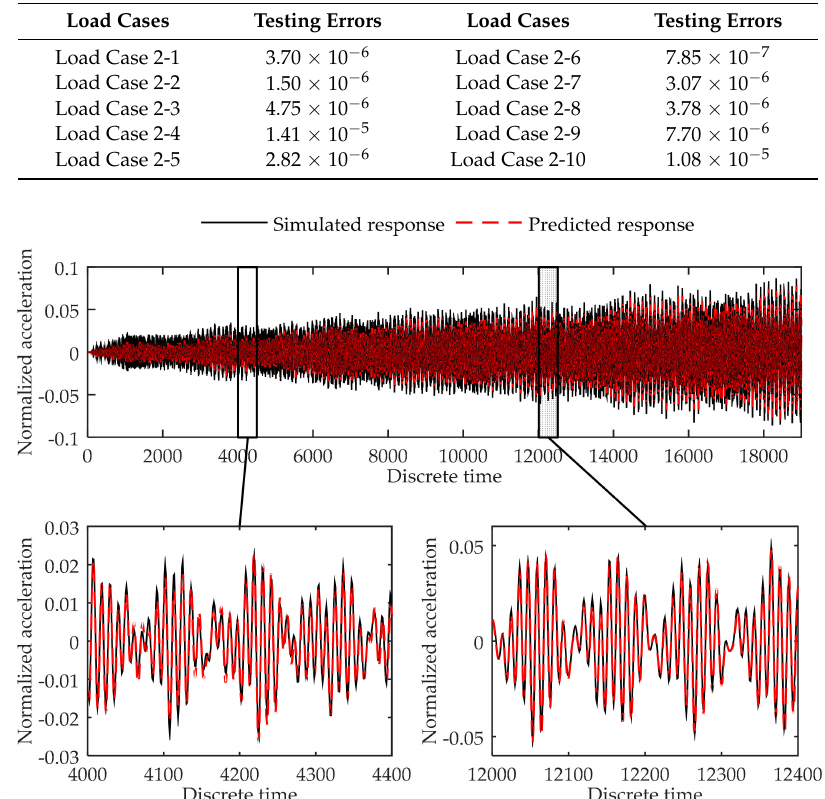
Figure 10. Comparison between the predicted response and simulated response of node 352 at the cantilever plate finite element model in Load Case 2-8.